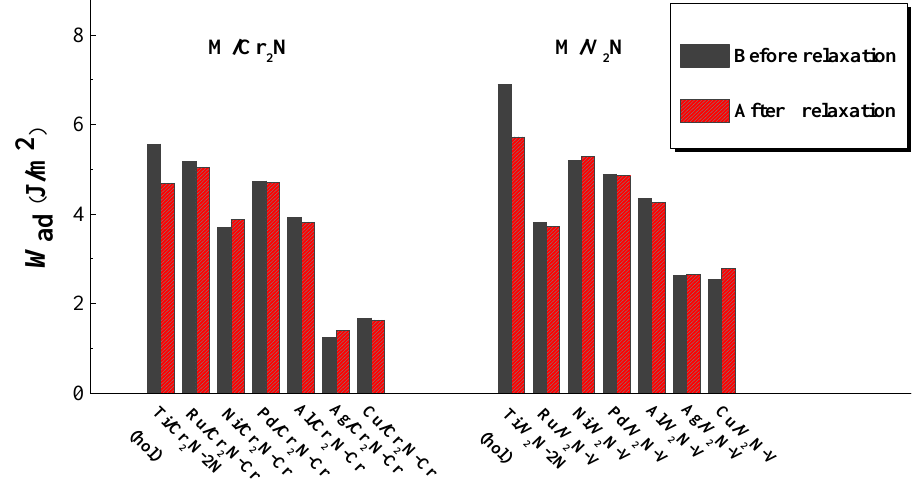
Figure 6. The work of adhesion W ad obtained for the interface models before and after full relaxation.